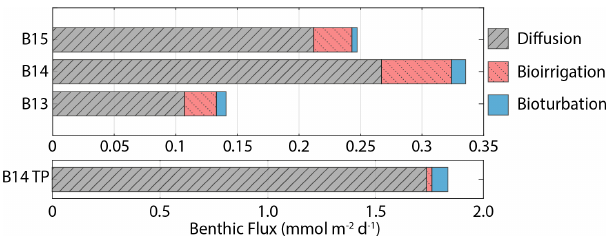
Figure 5. Benthic DSi flux magnitudes at the SWI calculated from steady state simulations, including contributions from molecular diffusion, bioirrigation and bioturbation. B14 TP refers to the B14 DSi flux magnitude at the peak of the transient simulations ( × 30 BSi depositional flux, 15yr − 1 k dissbloom , 1-week bloom